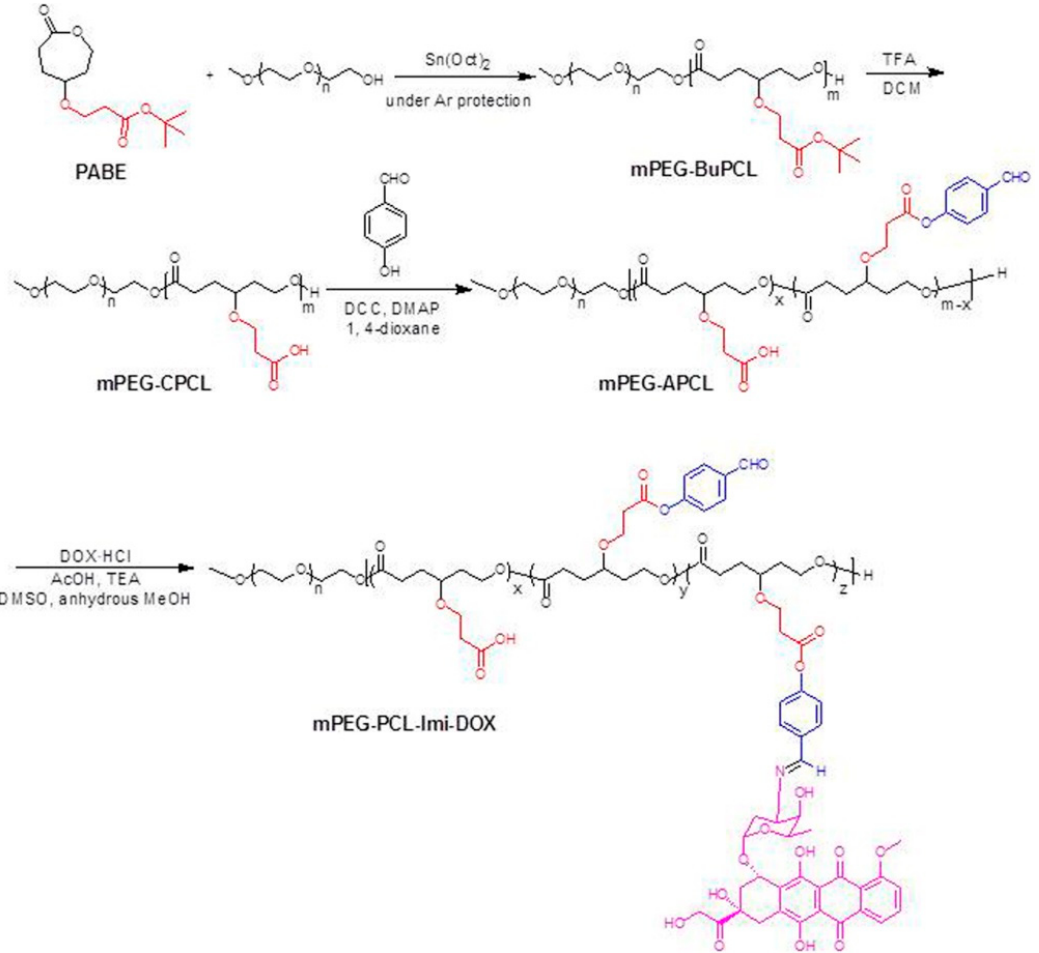
Figure 3. 1 H NMR spectrum of mPEG-PCL-Imi-DOX.